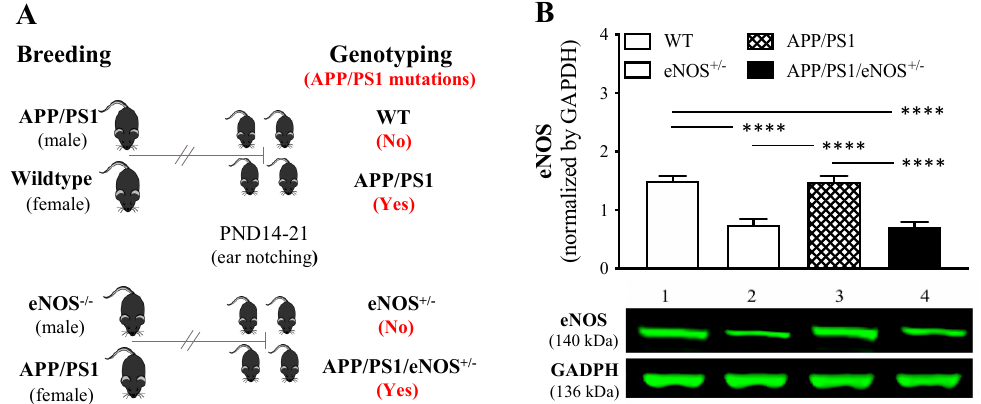
Figure 1. ( A ) Diagrams illustrating the breeding and genotyping scheme. Male APP/PS1 mice and female wildtype littermates were crossed to produce wildtype (WT) and APP/PS1 offspring, and the genotype of offspring was based on the absence (WT mice) or presence (APP/PS1 mice) of APPswe (APP) and PSEN1dE9 (PS1) mutations. Male eNOS − / − and female APP/PS1 mice were crossed to produce eNOS +/ − and APP/PS1/eNOS +/ − offspring, and the genotype of offspring was based on the absence (eNOS +/ − mice) or presence (APP/PS1/eNOS +/ − mice) of APP and PS1 mutations. Ear notching samples were collected from offspring on postnatal days (PND) 14–21 for genotyping. ( B ) mean (± SEM) eNOS protein levels (arbitrary unit, normalized by glyceraldehyde 3-phosphate dehydrogenase, GAPDH) in the anterior cortex of WT, eNOS +/ − , APP/PS1 and APP/PS1/eNOS +/ − mice ( n = 8–12/genotype). Representative western blots of eNOS and GAPDH in WT (1), eNOS +/ − (2), APP/PS1 (3) and APP/PS1/eNOS +/ − mice (4). **** indicates a significant effect between groups at p < 0.0001.